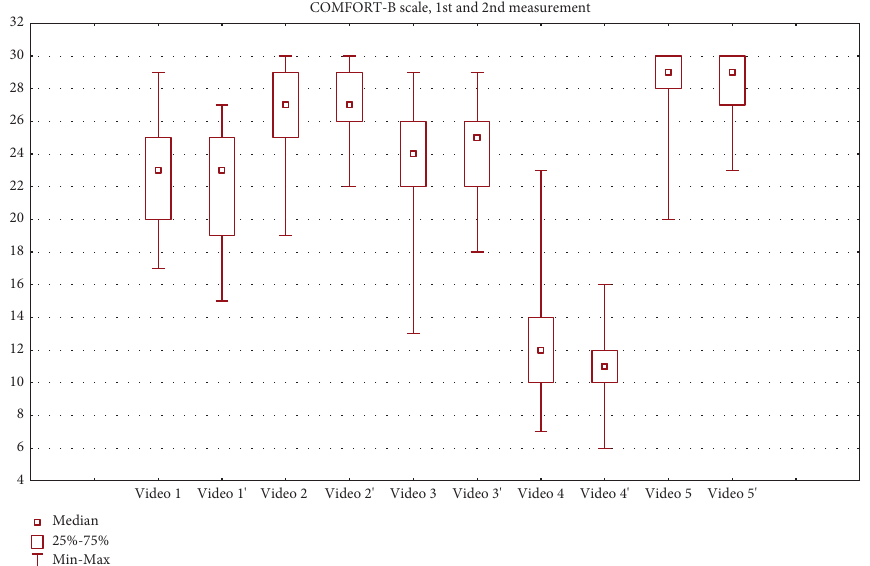
Figure 1: COMFORT-B scale scores. 2 nd measurements are marked with’.